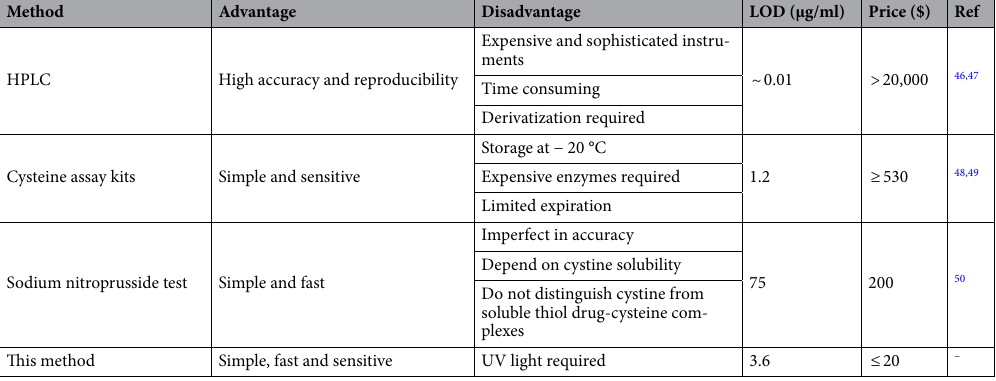
Table 3. Comparison between this method and conventional